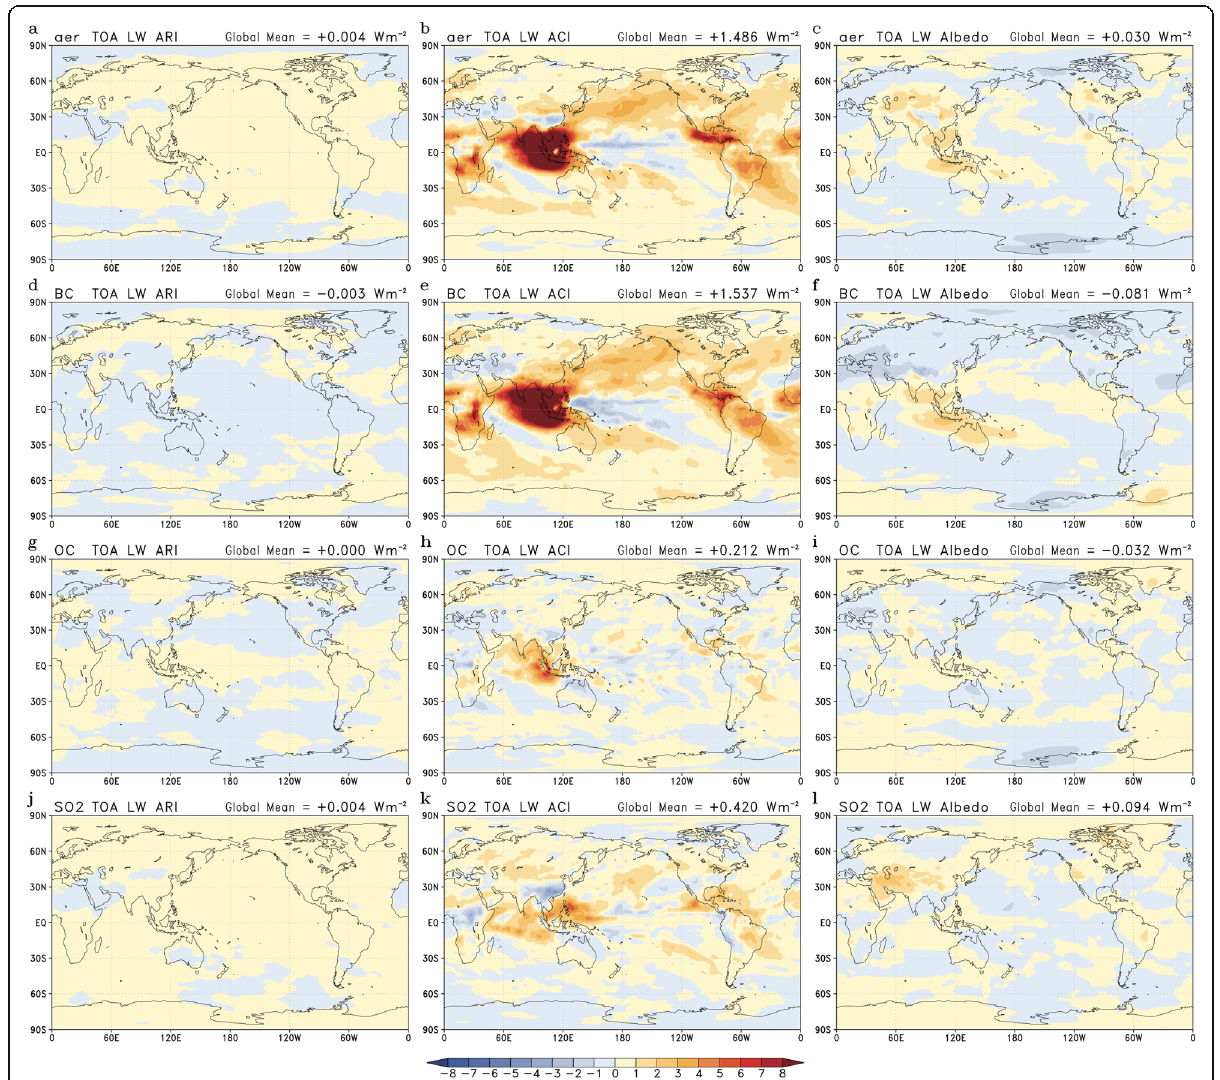
Fig. 5 Same as Fig. 4 but for longwave (LW)